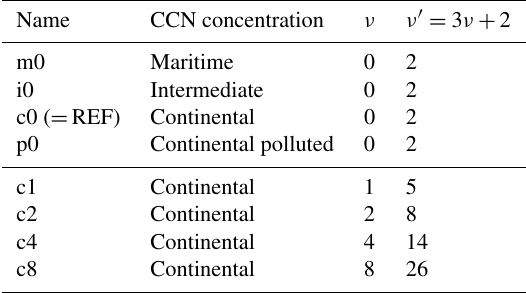
Table 1. Overview of the numerical simulations with shape param- eter values ν based on particle mass x and ν (cid:48) based on diameter D .